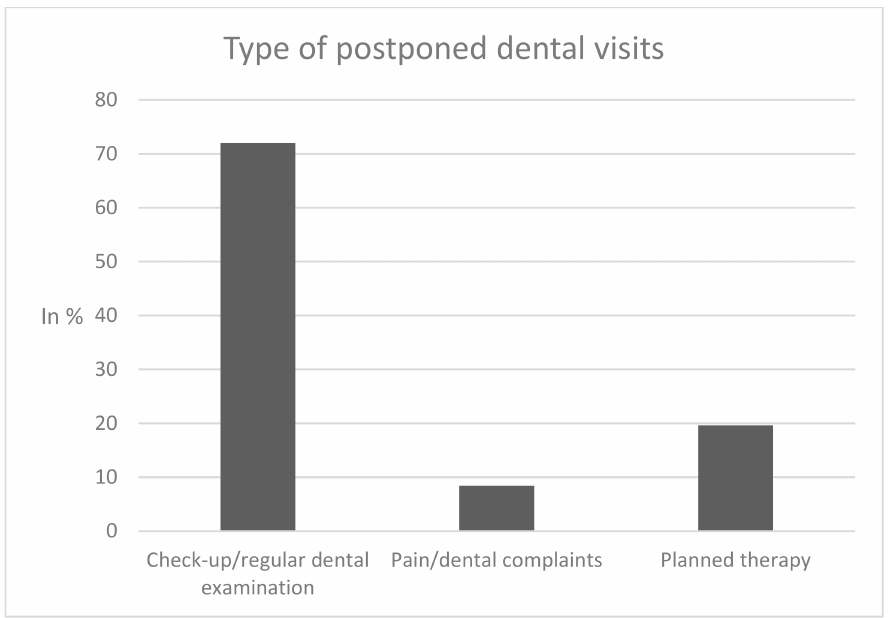
Figure 2. Type of postponed dental visits.